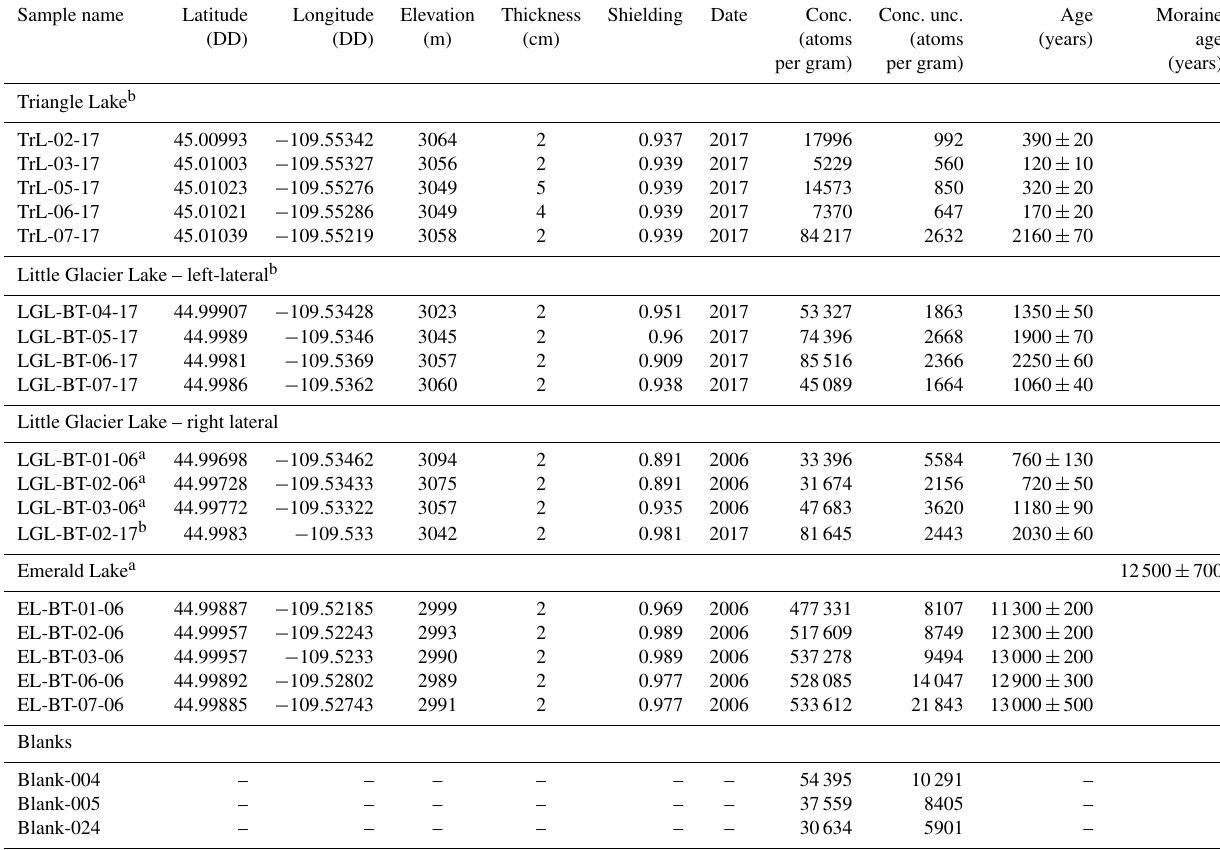
Table 1. Sample data and 10 Be